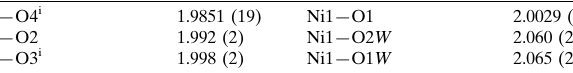
Selected bond lengths (A˚ ).